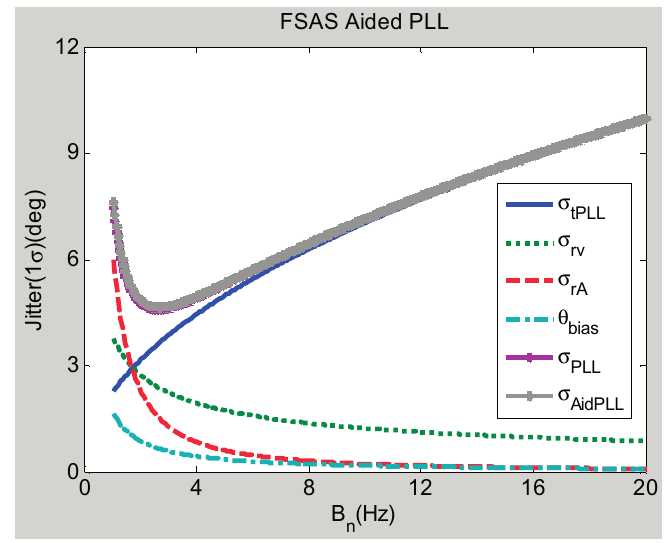
Figure 7. Tracking errors of medium-grade INS-aided PLL under static conditions. FSAS is a model of a typical medium-grade